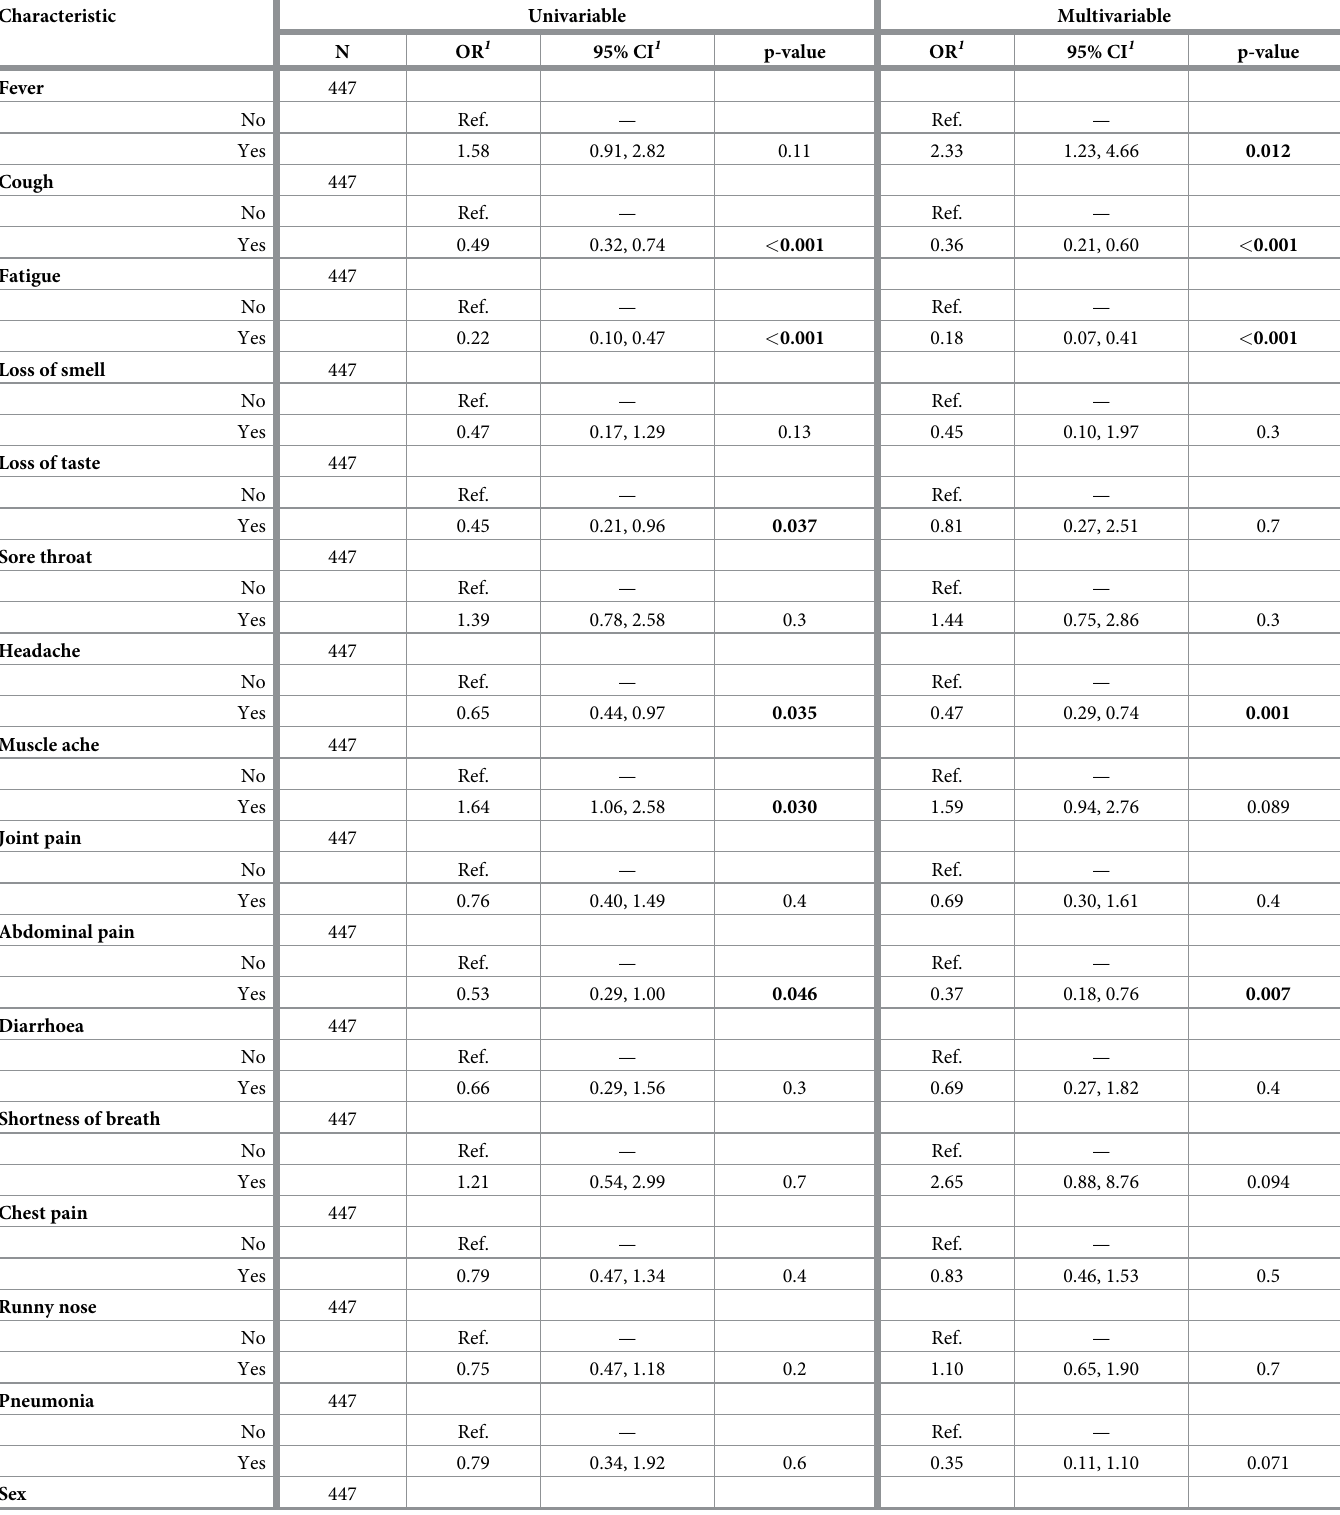
Table 5. Prevalence of symptoms among PCR-confirmed SARS-CoV-2 infected adult patients during pre-Omicron and Omicron